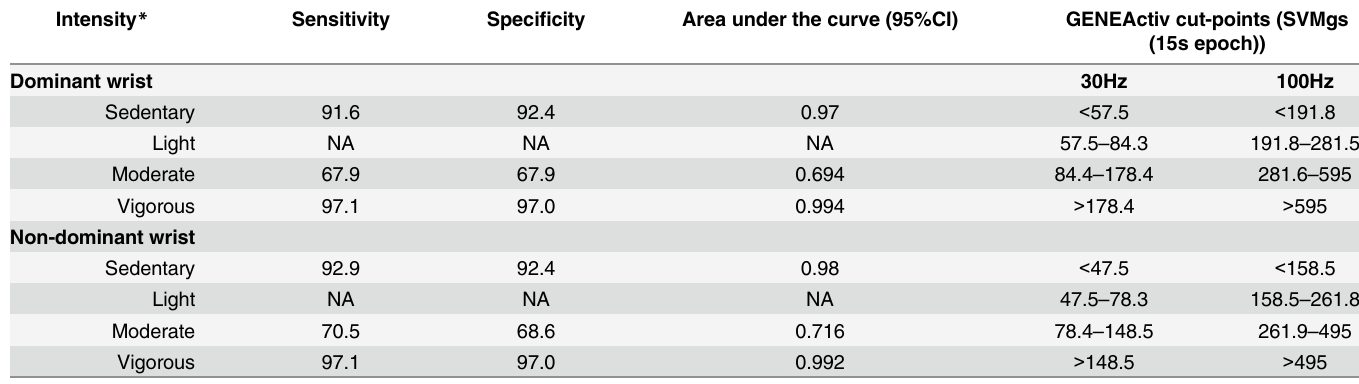
Table 1. Wear and non-wear time was identified by the procedure outlined by Van Hees et al., (2011) [13]. Non-wear time was calculated for each accelerometer axis on the basis of the stan- dard deviation (SD) and the value range. The procedure was carried out on successive blocks of 30 minutes. A block was categorised as non-wear time if the SD was less than 3.0 mg (1 mg = 0.00981 m.s -2 ) or if the value range was less than 50 mg, for at least two out of the three axes. Four-hundred and seventy-five subjects wore the accelerometer. One-hundred and sixty- six participants wore the GENEActiv accelerometer on their non-dominant wrist, 210 wore the device on their dominant hand while 21 did not have this data recorded. Choice of wrist was selected by the participant to ensure comfort and wear compliance, this decreased the likeli- hood of the participant removing the device and thus increased the quality and quantity of Table 1. Sensitivity, specificity, AUC and GENEActiv cut-points based on 3 and 6 METS. Intensity